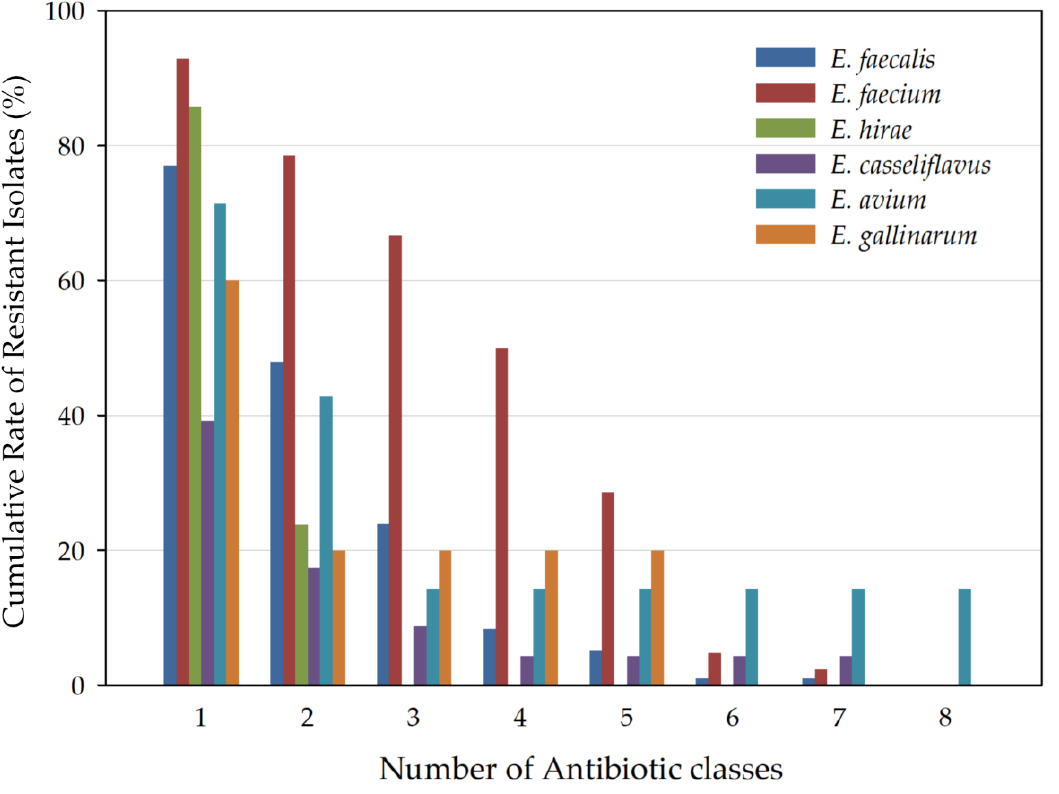
Figure 3. Cumulative percentages of multidrug resistance in Enterococcus isolates of six species. E. faecalis (23/96; 23.9%), E. faecium (28/42; 66.7%), E. avium (1/7; 14.3%), E. casseliflavus (2/23; 8.7%), E. canintestini (1/2; 50%), and E. hirae (0/21; 0%).